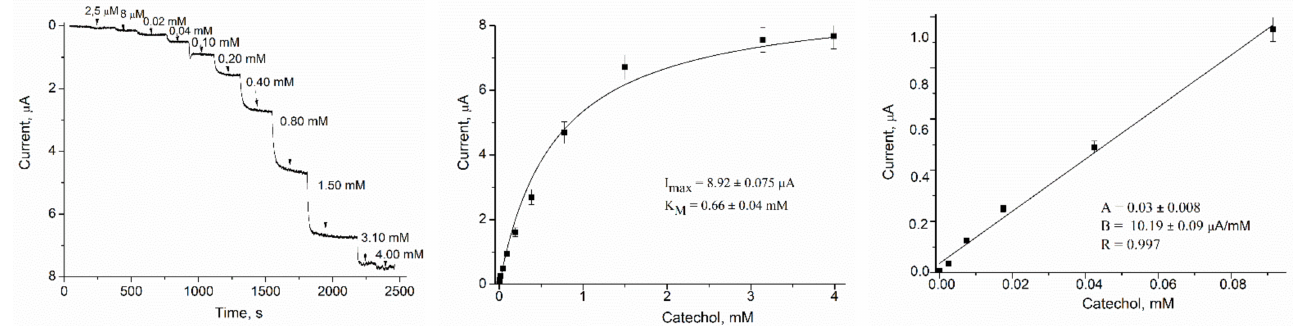
Figure A5. Chronoamperogram ( left ) and calibration curves for catechol determination in wide range ( middle ) and linear range ( right ) for the laccase/CuCo/GE, which contains 500 m-units of laccase and 1 µ g of NPs. Conditions: working potential +230 mV vs. Ag/AgCl, NaOAc buffer, 23 ◦ C.